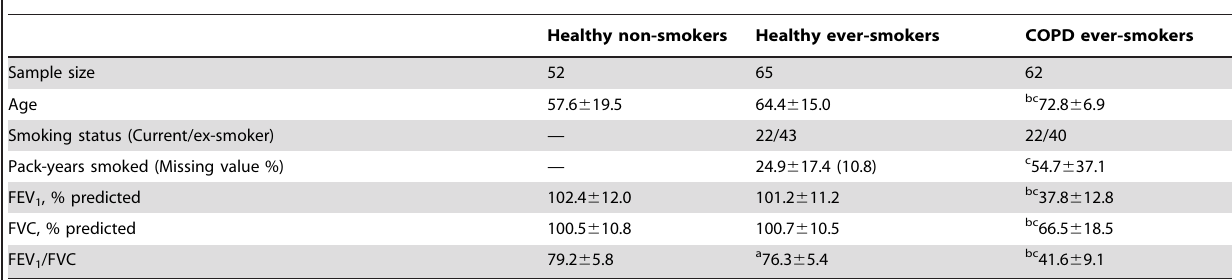
Table 1. Characteristics of study